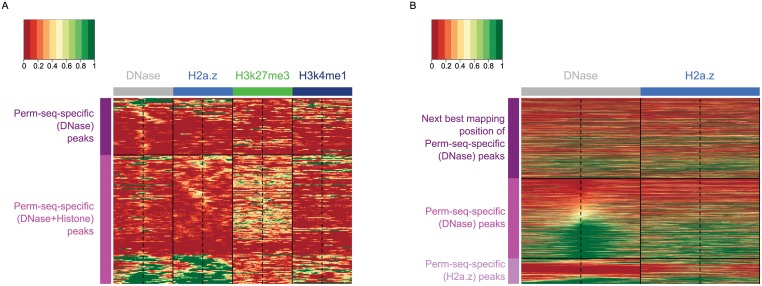
Perm-seq analysis of GM12878 Ctcf and Sin3a ChIP-seq dataset with DNase-seq and Histone ChIP-seq priors.(a) Heatmap of normalized DNase-seq and Histone ChIP-seq read counts for the [-1000 bps, +1000 bps] window anchored at GM12878 Ctcf peak summits depicted by the vertical dashed lines. Perm-seq-specific (DNase+Histone): Perm-seq optimal peaks using DNase-seq and Histone ChIP-seq in prior construction. These peaks are not identified when using only DNase-seq for prior construction or with CSEM. Perm-seq-specific (DNase): Perm-seq optimal peaks using only DNase-seq in prior construction. These peaks are not identified when using DNase-seq and Histone ChIP-seq for prior construction or with CSEM. (b) Heatmap of normalized DNase-seq and H2a.z ChIP-seq read counts for the [-500 bps, +500 bps] window anchored at GM12878 Sin3a peak summits. Perm-seq-specific (DNase): Perm-seq optimal peaks using DNase-seq in prior construction. These peaks are not identified when using only H2a.z ChIP-seq for prior construction or with CSEM. Perm-seq-specific (H2a.z): Perm-seq optimal peaks using only H2a.z ChIP-seq in prior construction. These peaks are not identified when using DNase-seq for prior construction or with CSEM. Next best mapping positions of Perm-seq-specific (DNase) peaks denote the regions where the multi-reads of the peaks map with the next best total allocation scores, i.e., ranked second compared to the allocation scores at the actual peaks.